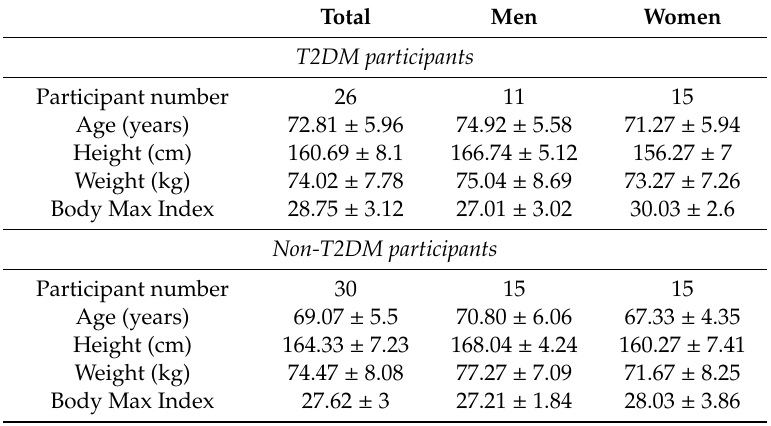
Table 1. Characteristics of the participants included in the